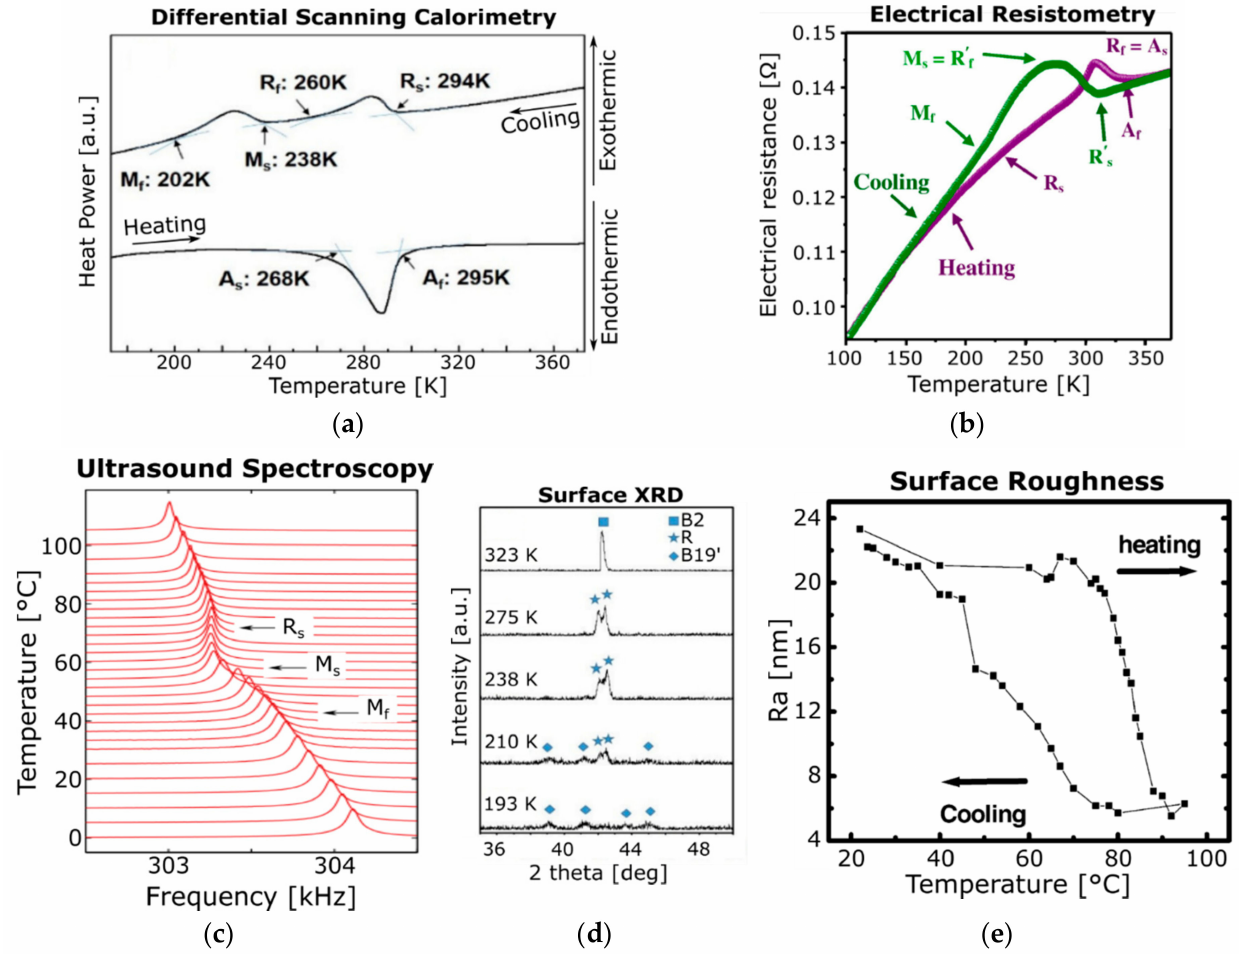
Figure 5. Results of different methods used to evaluate the phase transformation temperatures in SMA films. ( a ) Differ- ential Scanning Calorimetry of NiTi film reproduced from [122]; ( b ) Electrical resistance evolution of NiTi/PZT/TiOx heterostructure reproduced from [123] with permission from Elsevier 2011; ( c ) Evolution of the resonant spectra of the NiTi film sputtered on Si substrate reproduced from [125] with permission from Elsevier 2015; ( d ) Surface X-Ray diffraction evolution of NiTi film reproduced from [122]; ( e ) In-situ surface roughness measurement upon heating/cooling of NiTi film sputtered on Si substrate reproduced from [39] with permission from Elsevier